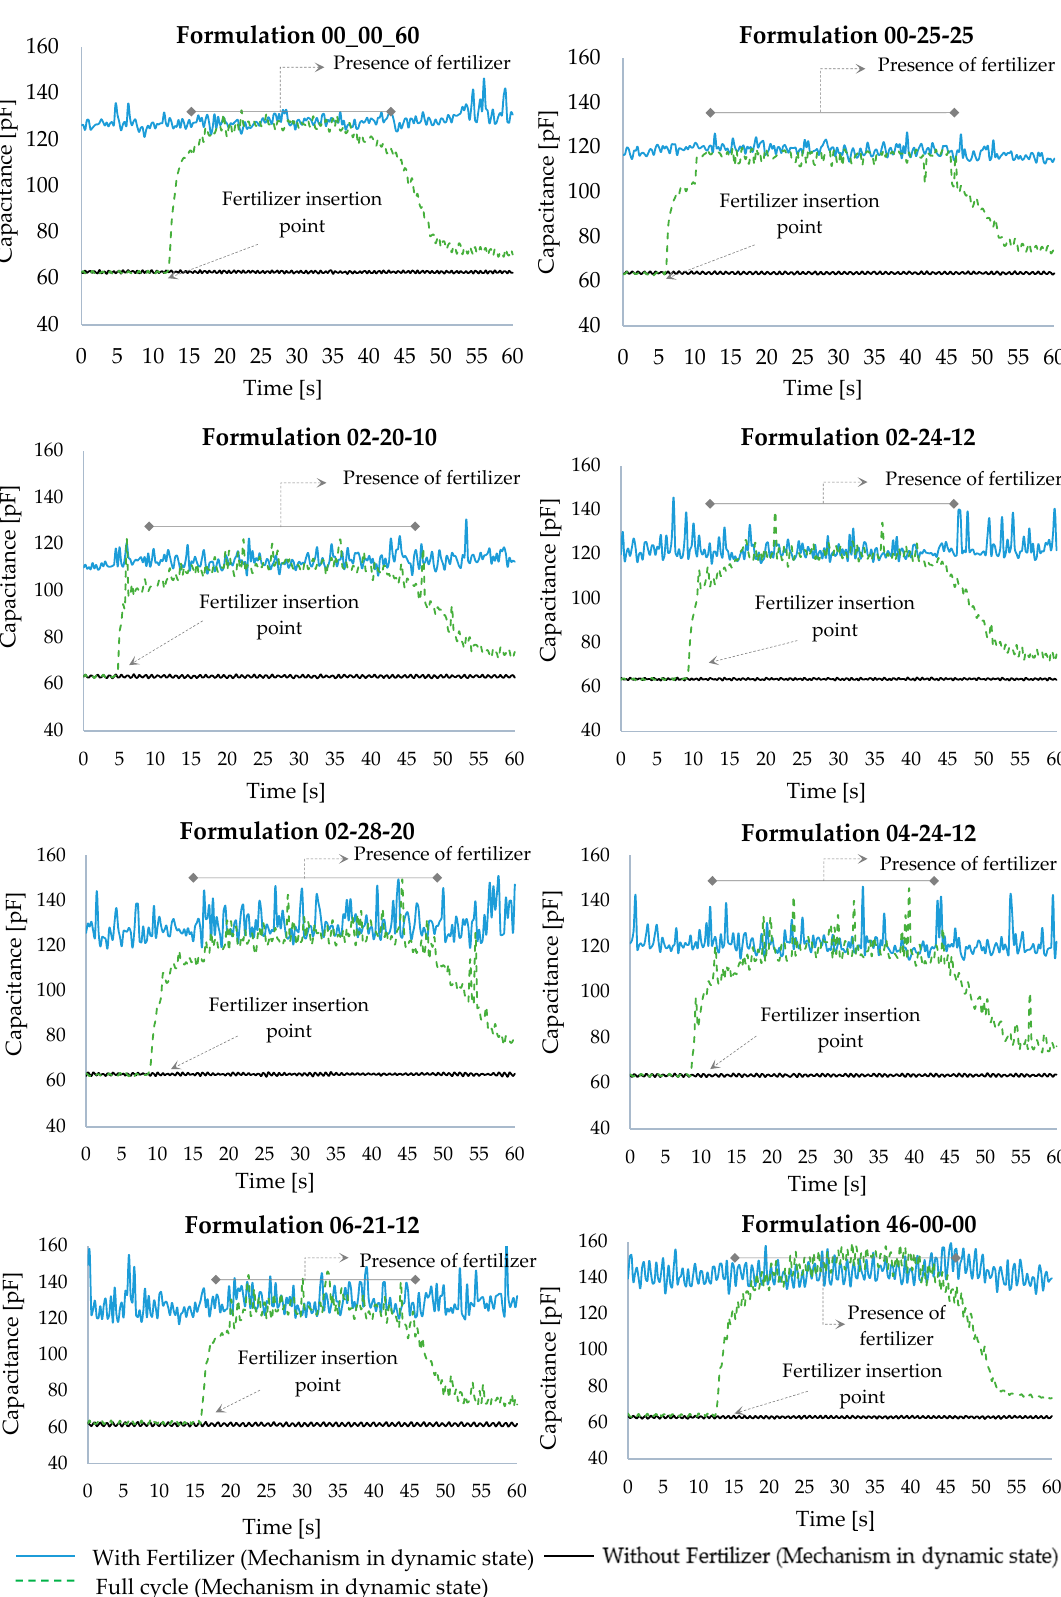
142.98 SDV—standard deviation; VC—variation coefficient; MAX—maximum; MIN—minimum; MEA— mean. Analyzing the data dispersion measurements presented in Table 3, where VC expresses the extension of the data variability in relation to the population mean in percentage, and the SDV refers to the error in relation to the population area, the highest VC and SDV were presented in dynamic mode with the presence of fertilizers in the formulation 06-21-12 with values of 5.53% and 7.14 pF, respectively; greater data dispersion was seen in this formulation around the arithmetic mean. However, all the formulations presented a VC below 10%, indicating data homogeneity and low